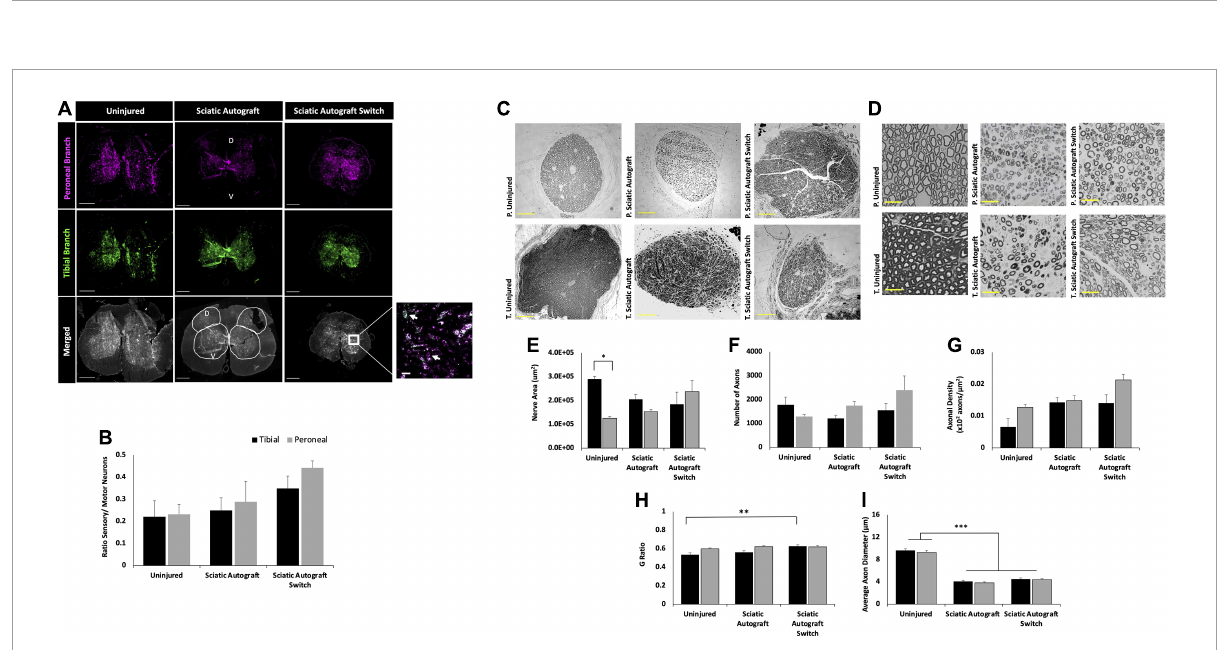
FIGURE4 Sciatic autograft and sciatic autograft switch retrograde labeling and nerve morphometry. (A) Retrograde labeled spinal cords showing peroneal (magenta) and tibial (green) branch labeling. The dorsal and ventral horns are outlined in the merged image for the sciatic autograft group. Box in the merged image of the sciatic autograft switch column shows a 20 × magnification, scale bar is 20 µ m. Arrows indicate labeled neurons. Scale bars are 500 µ m. (B) Ratio of sensory/motor neurons counted from the peroneal (magenta) and tibial (green) nerves. (C) Cross section images of the peroneal and tibial nerves taken at 10 × . Scale bars are 200 µ m. (D) 40 × images of the toluidine blue stained sections from within the grafts; labeling of images is based on connection of the branch in the graft to the hosts peroneal or tibial distal nerve stump. Scale bars are 20 µ m. (E) Total cross sectional nerve area taken for the tibial and peroneal branches. (F) Total number of axons. (G) Axonal density. (H) G-ratio. (I) Average inner x and y plane axon diameter. n = 5 for sciatic autograft, n = 6 for sciatic autograft switch, ∗ p < 0.05, ∗∗ p ,0.01, ∗∗∗ p < 0.001 by two-way ANOVA with Tukey post-hoc test. Error bars are